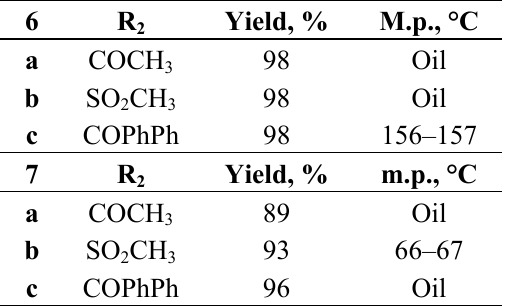
Table 4. Synthesis of amides 6 and 4-methyl-1,2,3,4-tetrahydroisoquinolines 7